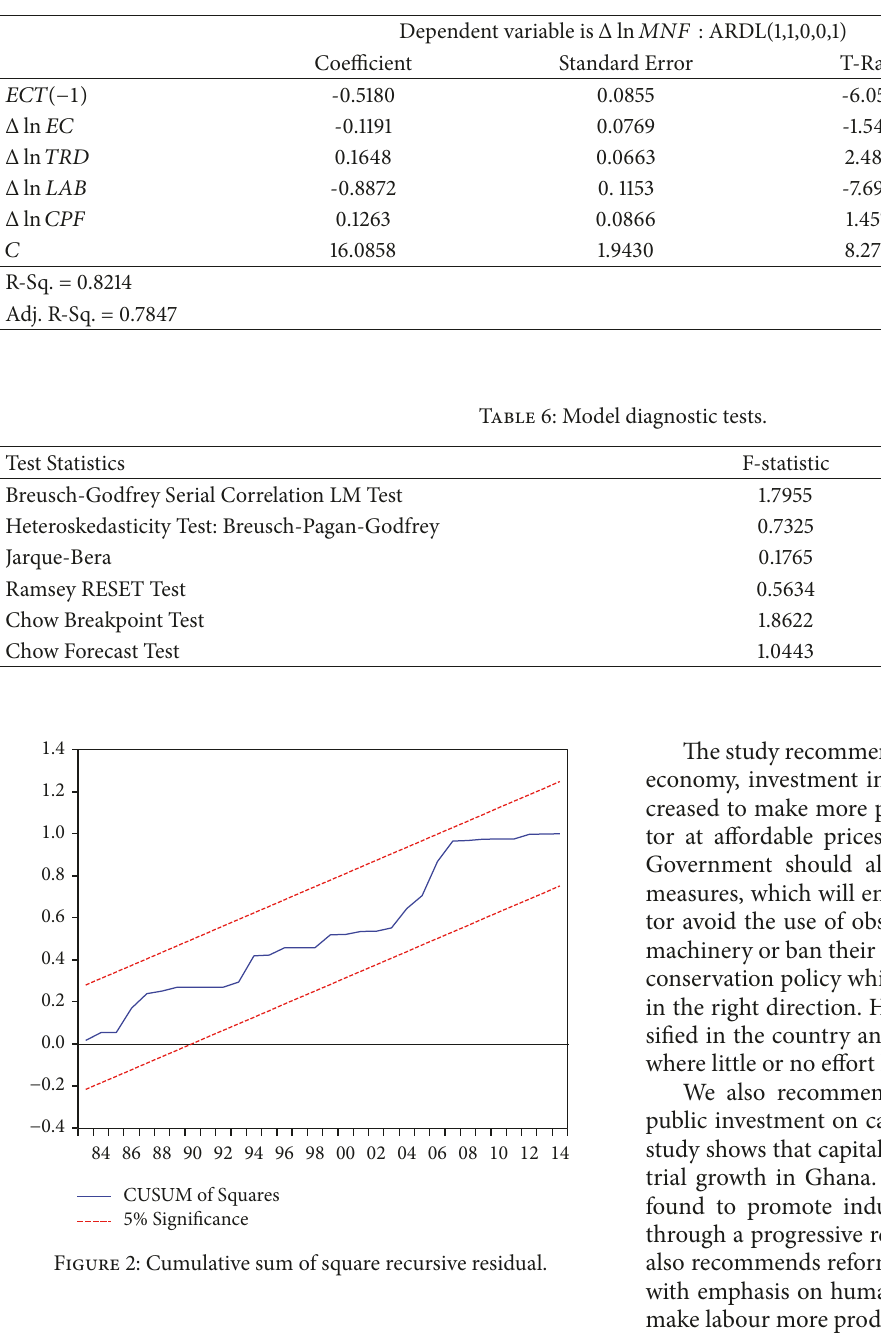
Table 5: Short-run estimates.